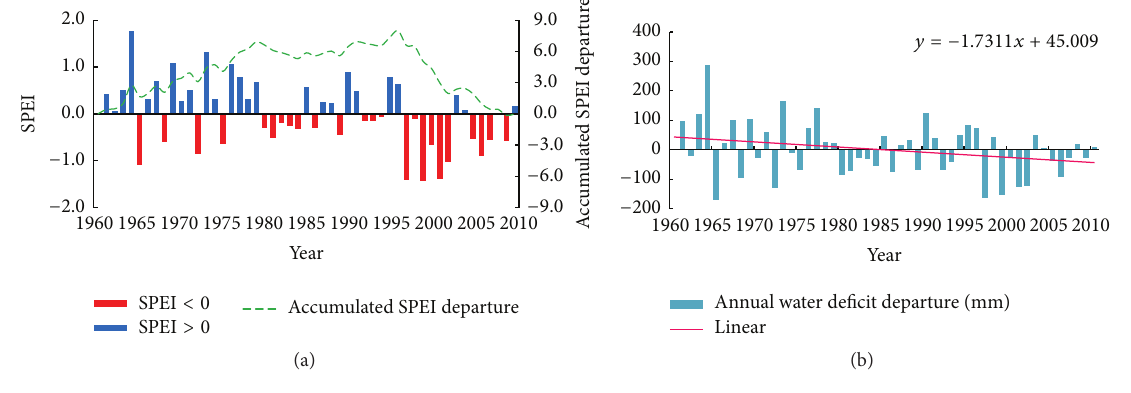
Figure 2: The interannual variability of annual SPEI value (a) and annual water deficit